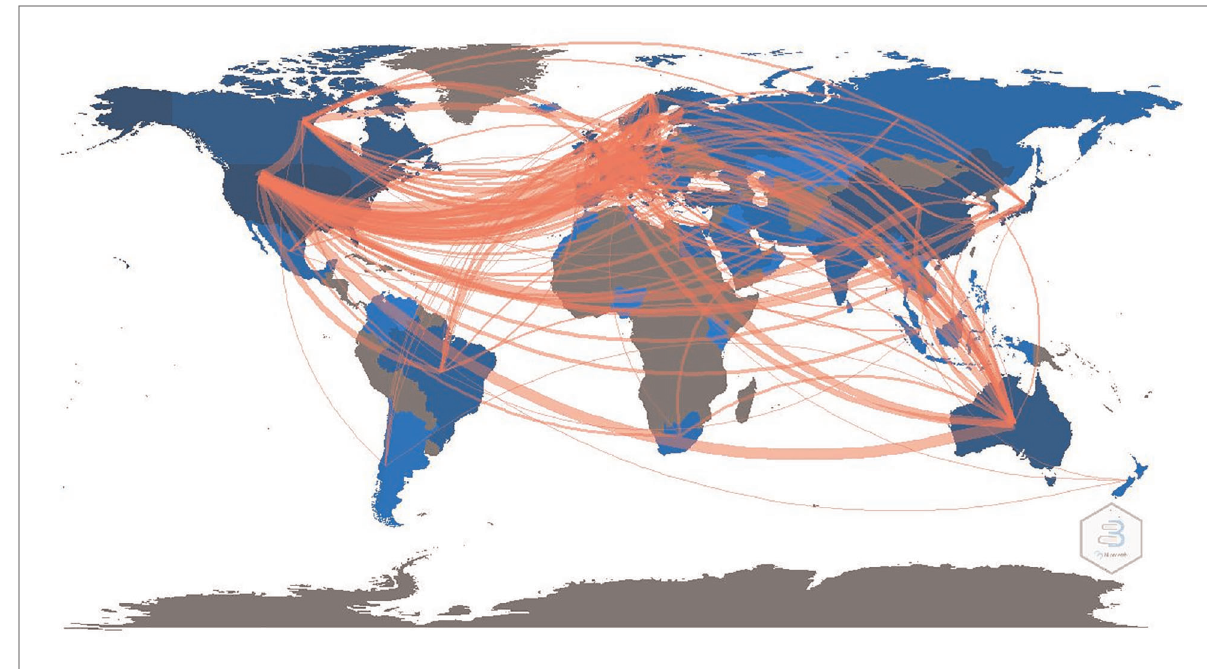
FIGURE 5 The world map shows the contribution of every country based on paper counts.